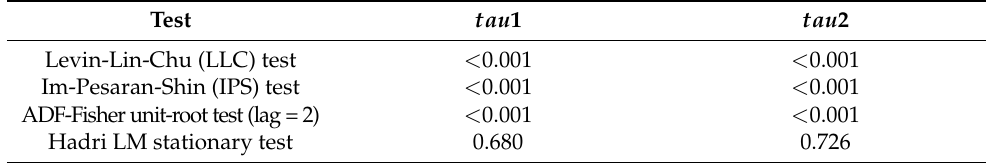
Table 2. The results support that both τ 1 and τ 2, CRRA are stationary for all panels. Table 2. Panel Data Unit-Root/Stationary Test ( p